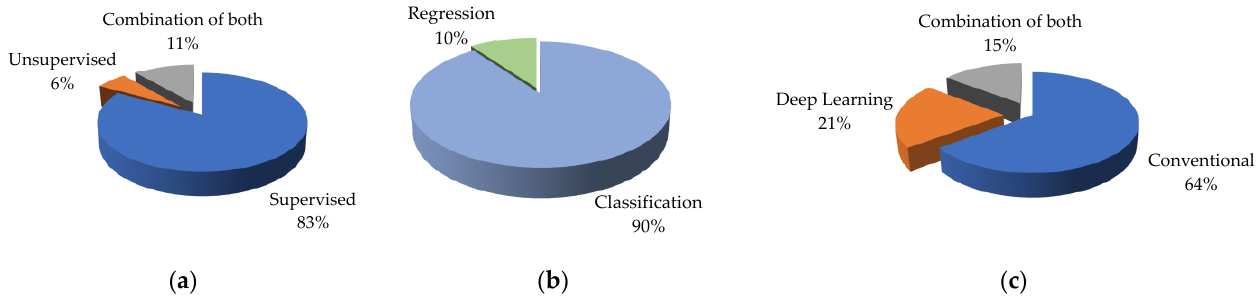
Figure 4. Type of ML techniques employed in the reviewed papers: ( a ) type of learning; ( b ) type of problem; ( c ) type of ML model.